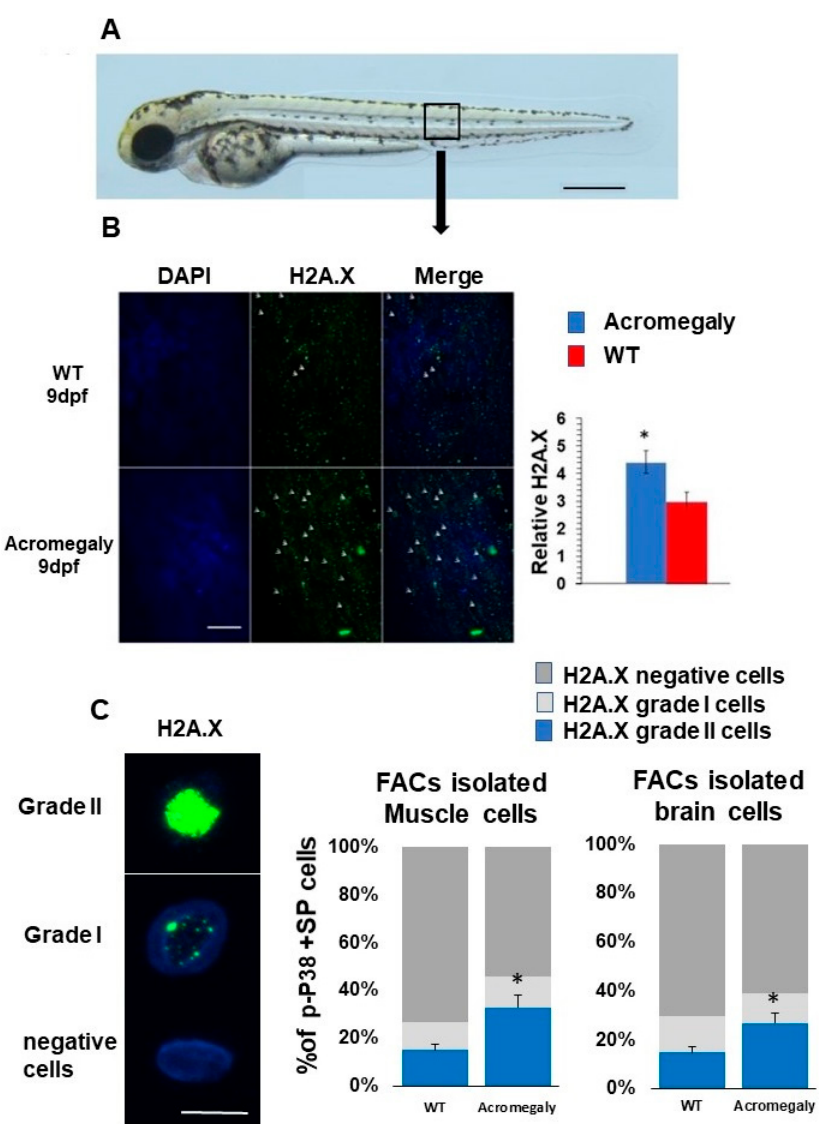
Figure 3. Increased DNA damage in Acromegaly zebrafish larvae and adult. ( A ) A zebrafish larva showing the area for taking the image for H2A.X quantification (black box). Bar = 500 µ m. ( B ) Representative H2A.X whole-mount immunostaining and quantification in acromegaly and WT zebrafish (9 dpf) showing a significant increase in the number of H2A.X stained cell nuclei in the